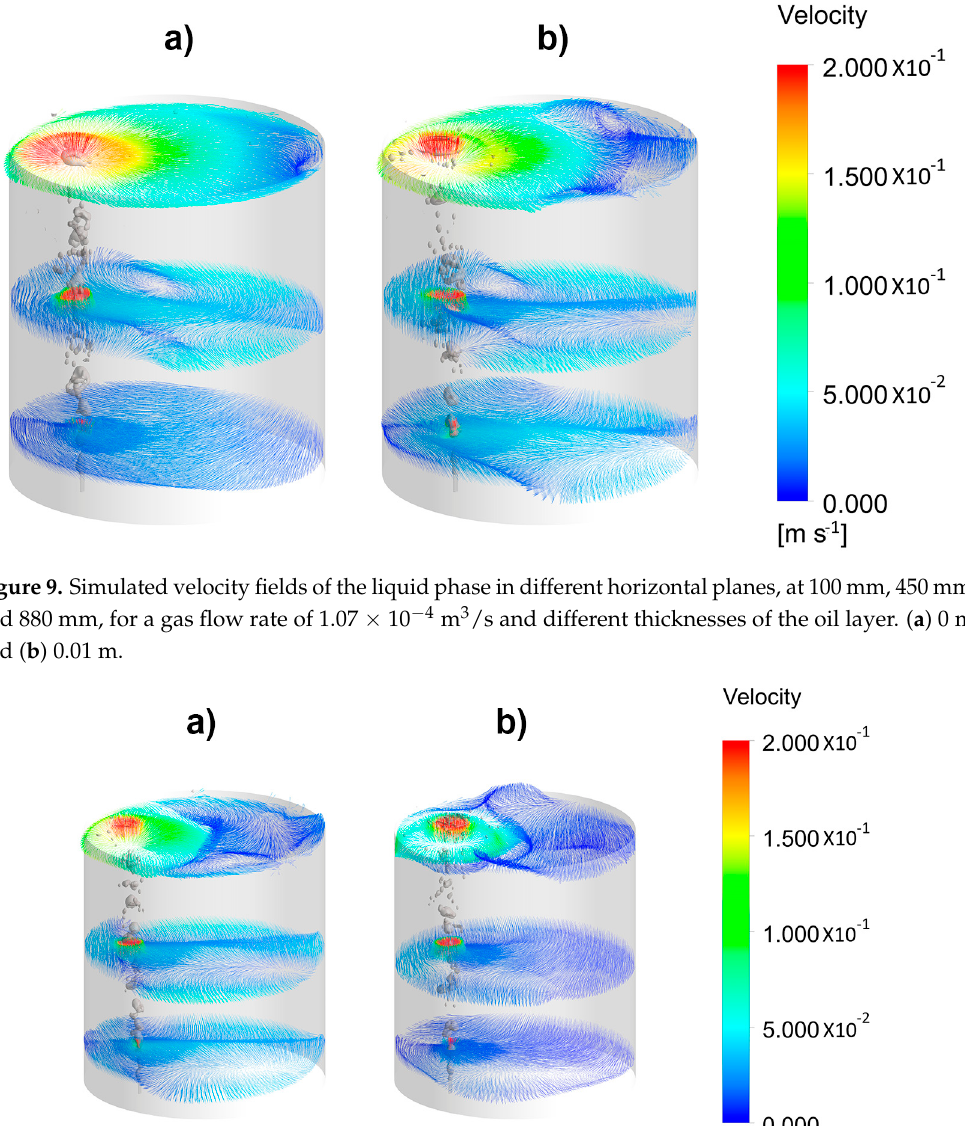
Figure 10. Simulated velocity fields of the liquid phase in different horizontal planes, at 100 mm, 450 mm, and 880 mm, for a gas flow rate of 1.07 × 10 − 4 m 3 /s and different thicknesses of the oil layer. ( a ) 0.02 m and ( b ) 0.04 m.